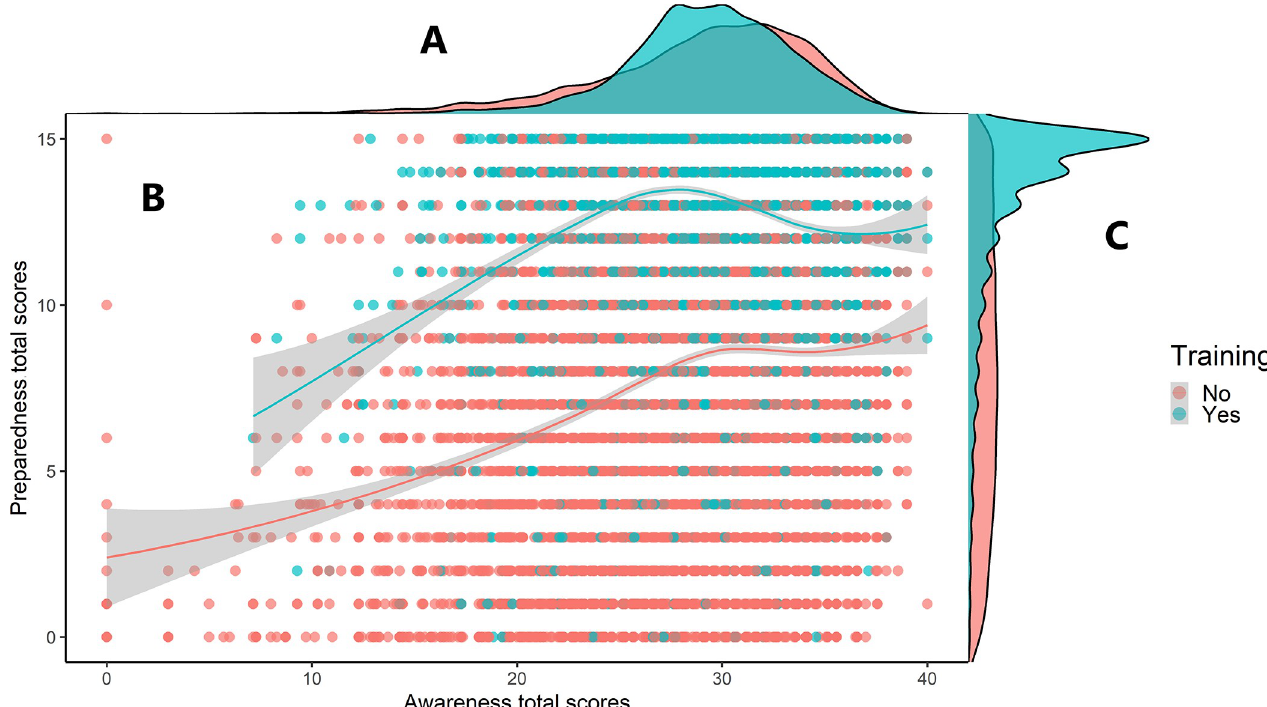
Fig 3. Two multivariate cowplots illustrating the effect of training on preparedness and awareness. Part A illustrates the distribution of awareness scores. Part B shows individual total scores of preparedness and awareness. The center lines were computed using Loess method with the shadow representing their 95% confidence intervals. Part C illustrates the distribution of preparedness